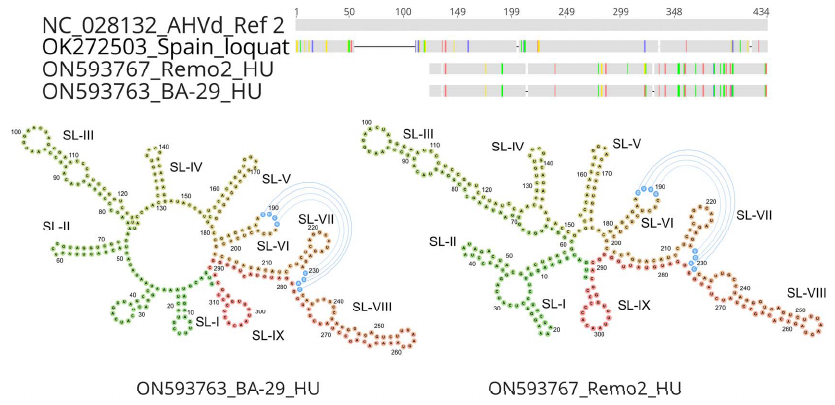
Figure 5. Alignment and secondary structure prediction of AHVd variants with deletions. The upper part shows the differences within their coding region, while the lower part shows the modelled secondary structures of the BA-29 and Remo2 AHVd isolates prepared using Vienna RNAfold software. The predicted stem-loops (SL-I to SL-IX) are indicated. Residues involved in the kissing- loop interaction are labelled by blue circles and lines.